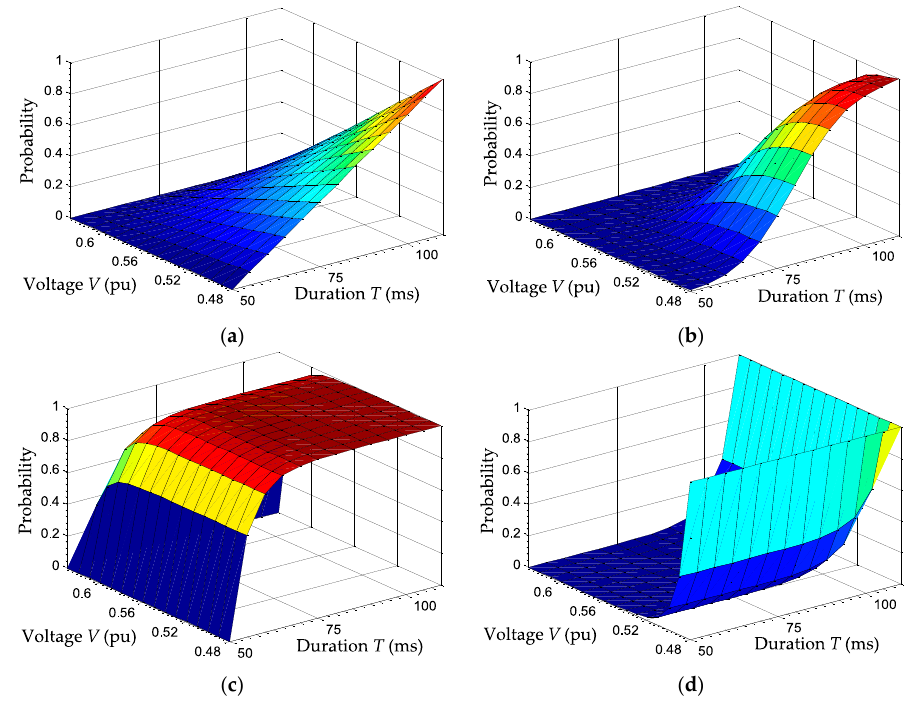
Energies 2017 , 10 , 401 18 of 27 Figure 16. Probability of occurrence for voltage–tolerance characteristics for PC with assuming various density functions: ( a ) uniform; ( b ) normal; ( c ) exponential; and ( d ) reverse exponential.